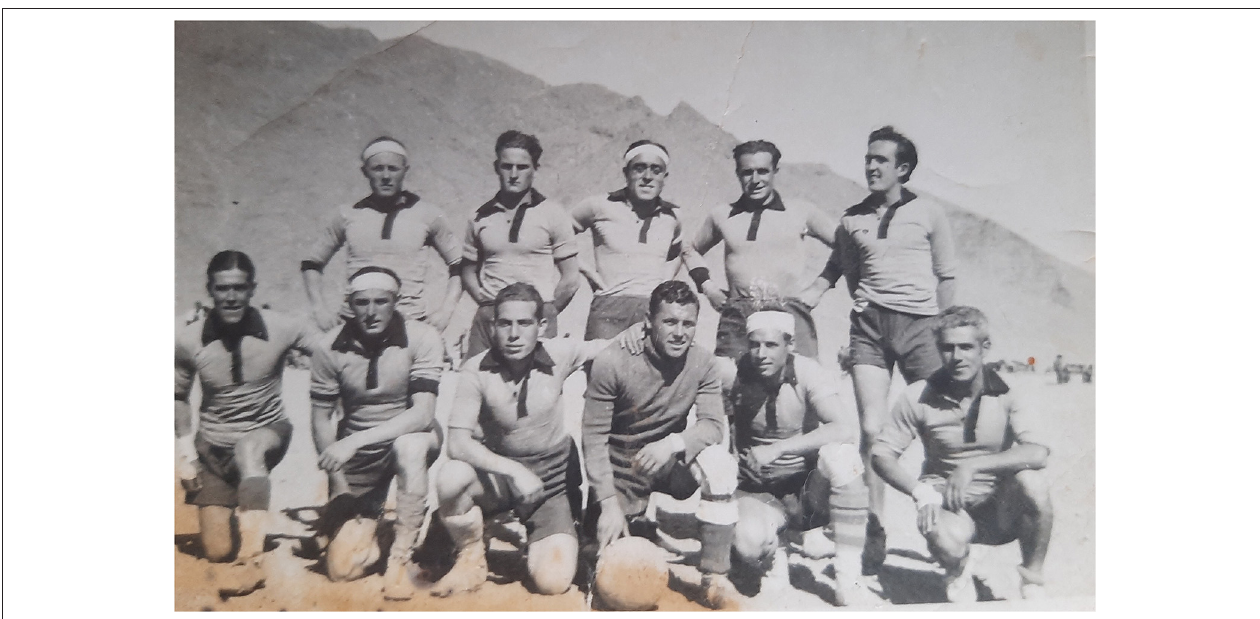
FIGURE 4 | Antonio Cánovas (the crouching man with dark jersey) and his Bou Arfa concentration camp teammates (1941). Source: Cánovas family